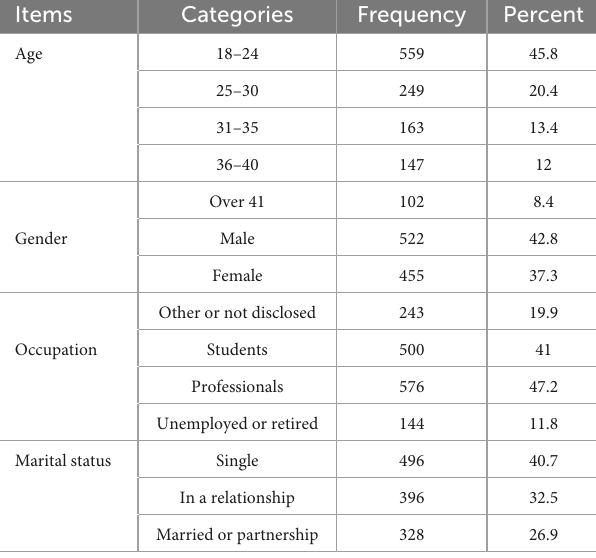
TABLE 1 Demographic information of the